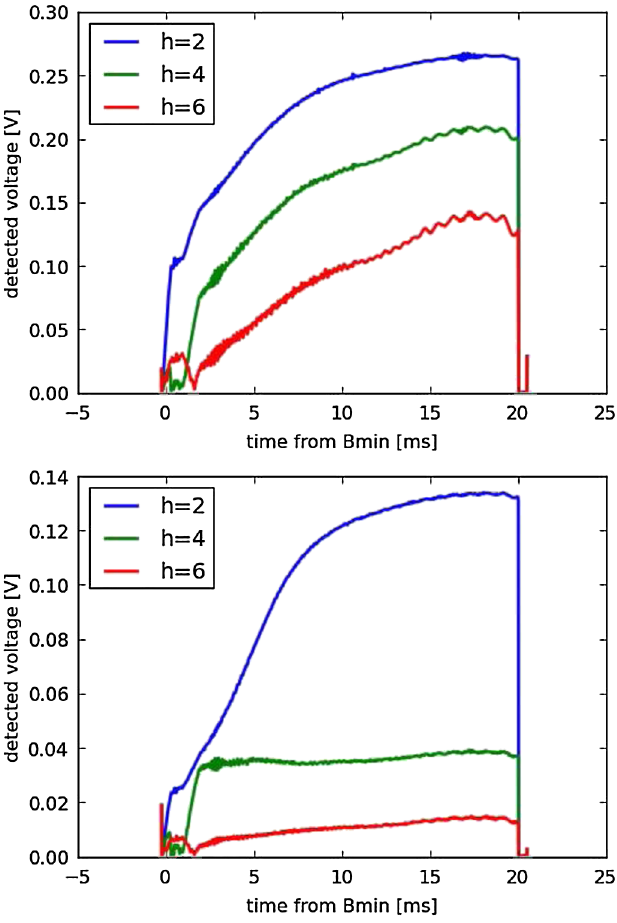
domain.FIG. 7. The harmonic components of the WCM signal (top) and cavity #10 gap monitor